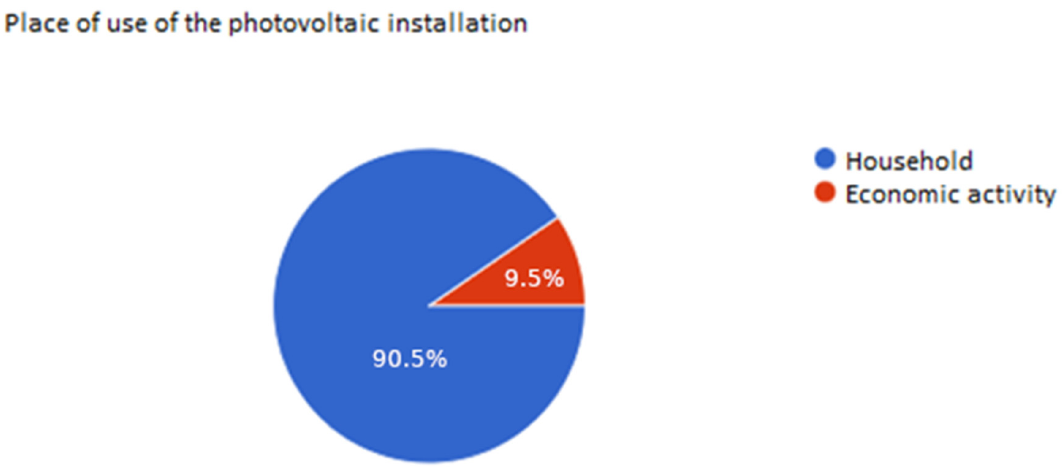
Figure 25. Place of use of the photovoltaic installation.